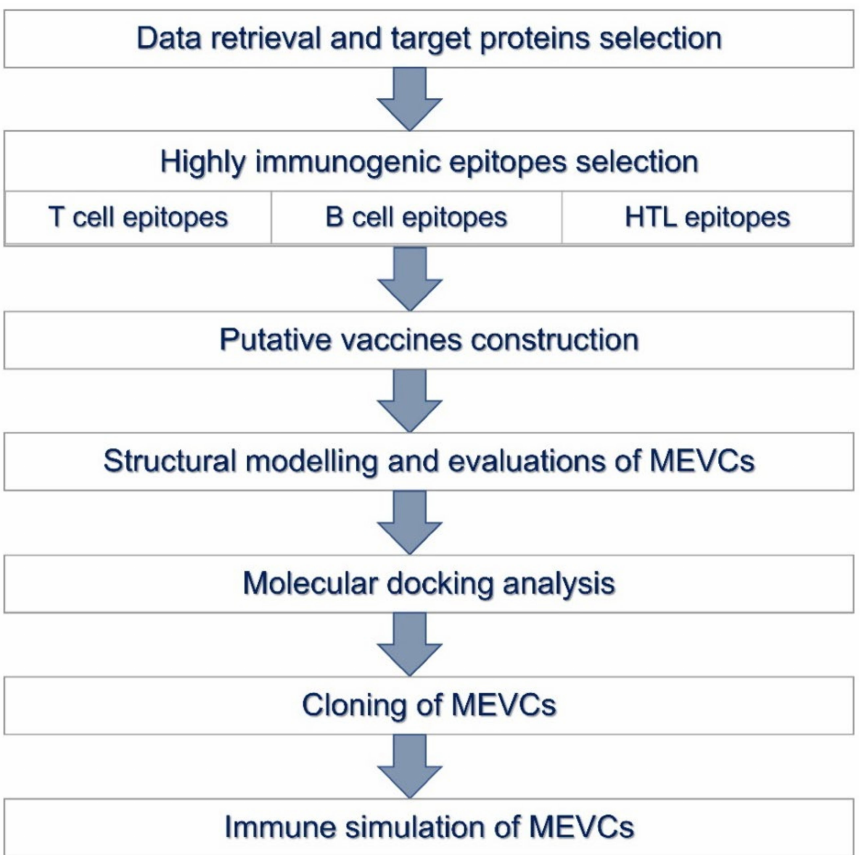
Figure 1. The overall workflow of the study design adapted in the construction of